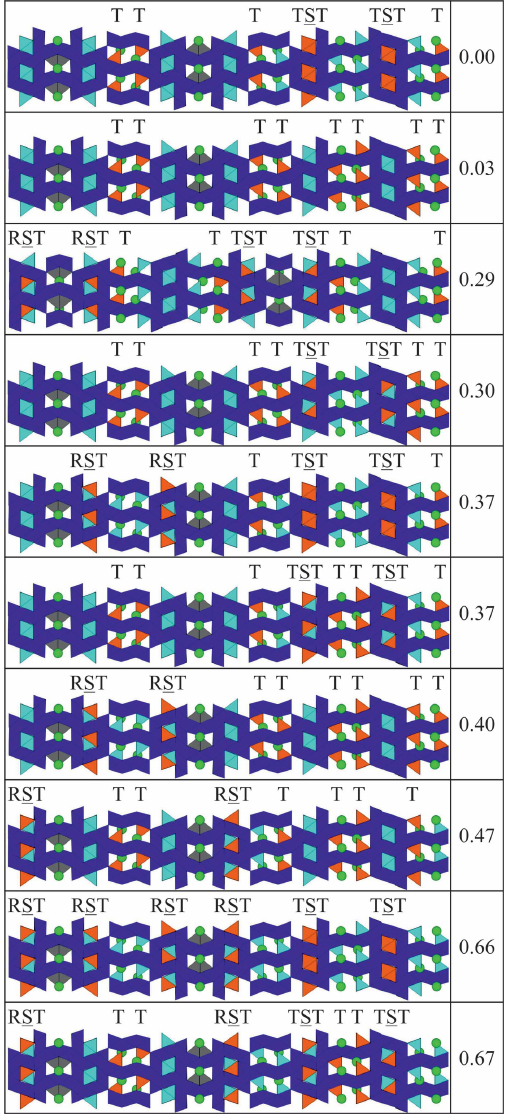
Figure 14 The structures generated by populating Zn atoms in different symmetry- related groups of tetrahedral sites for the (34) 3 hexaferrite, with their computed energies above the most stable configuration in eV. The unit cells contains a threefold repeat of the sequences shown. In each structure, the 24 zinc atoms are distributed over four groups of symmetry- related tetrahedral sites, each of which contains six tetrahedra (coloured orange). Fe octahedra are shown in dark blue, with bipyramids in grey and tetrahedra in light blue.